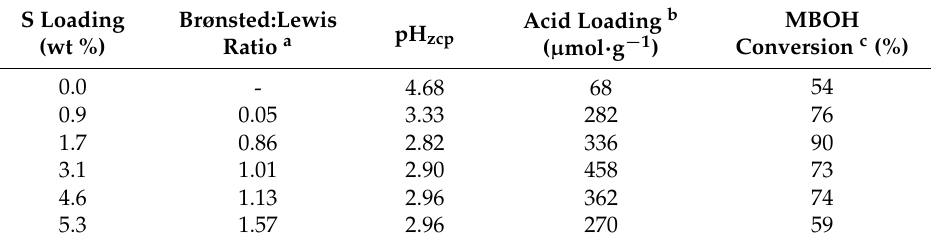
Table 3. Surface acidity of parent and sulfated Table 3 . Surface acidity of parent and sulfated zirconia.